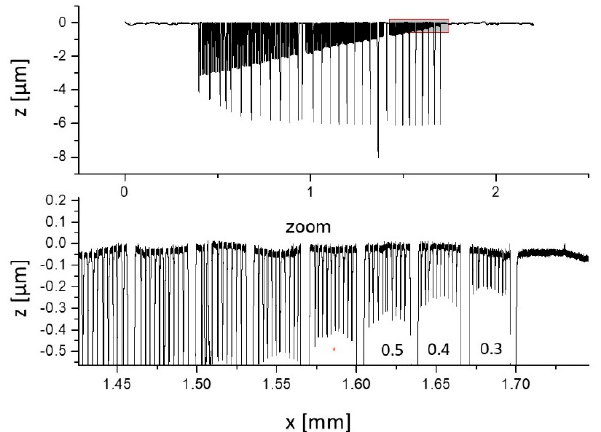
Figure 13. Complete profile measurement on the tip-testing standard (top) and zoomed section showing the profile for the smallest grooves (bottom).